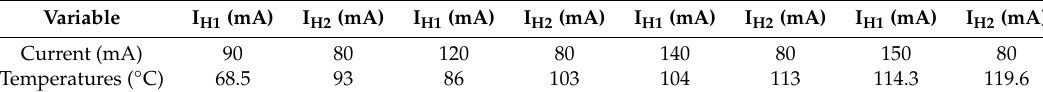
Table 2. Simulated maximum temperatures on the smaller heater H 1 and the larger heater H 2.